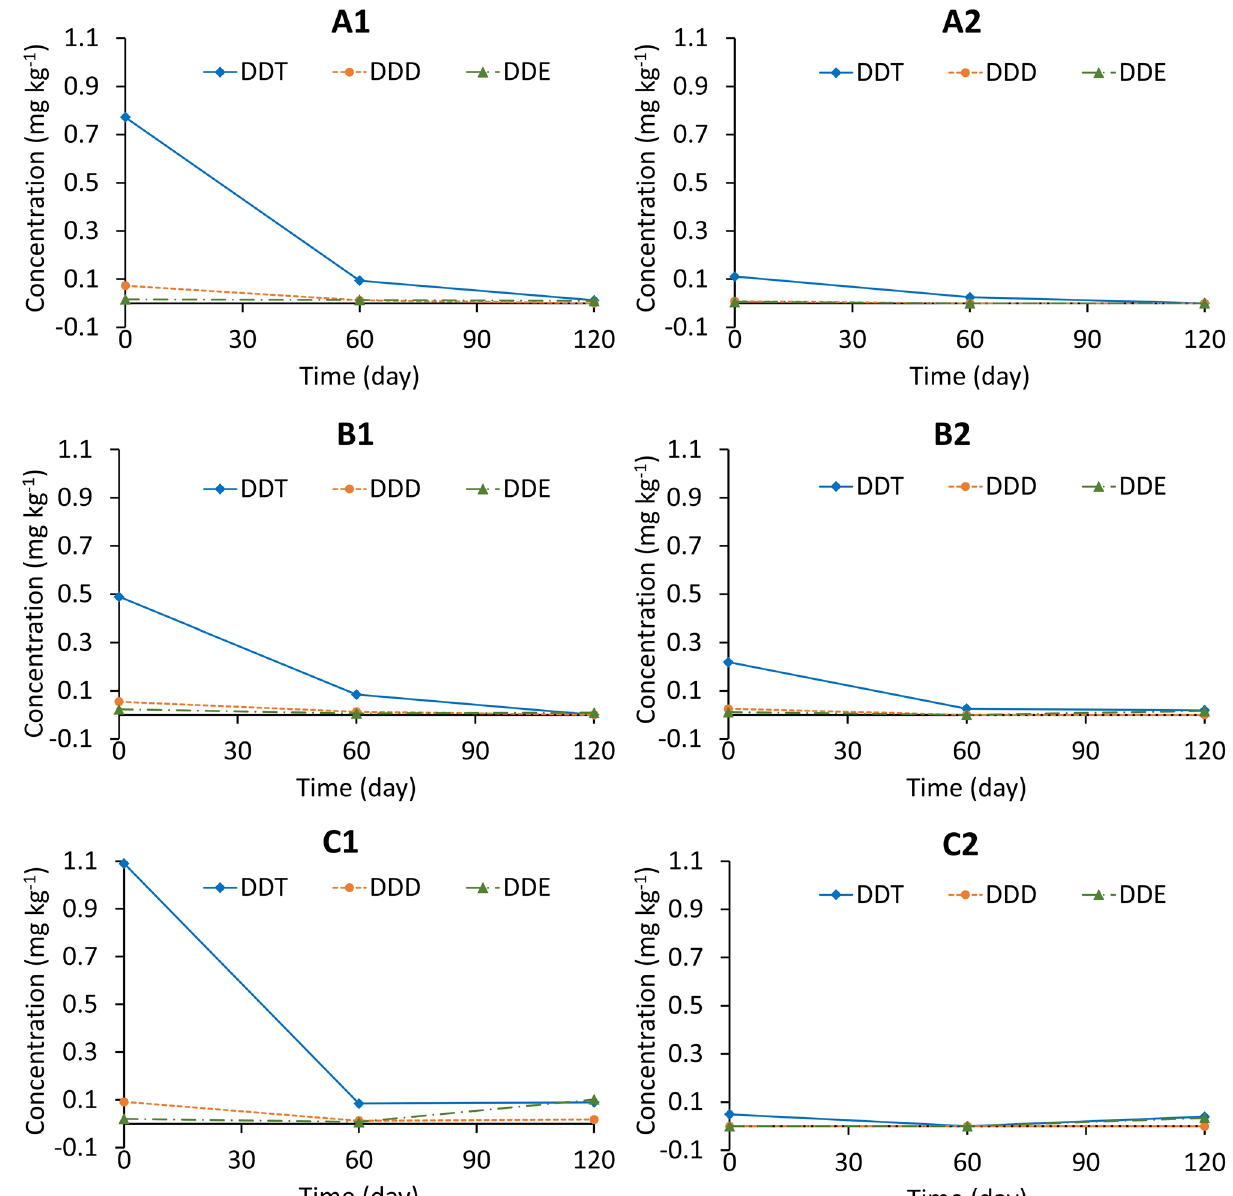
Figure 2. Removal of DDTs in soils at the trial site. A1, A2, B1, B2, C1 and C2 denote lots with different soil treatments as described in Table 2. Data in day 120 for A2 are missing because the concentration was below LOD.